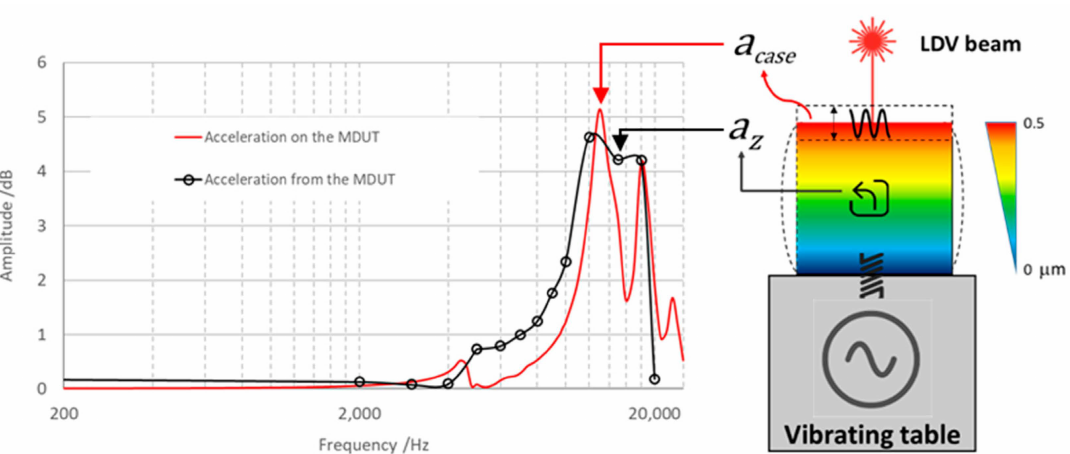
Figure 13. Comparison between the acceleration amplitude, a case , measured on the upper surface of MDUT by the Laser-Doppler Vibrometer (red curve), the acceleration amplitude, a z , measured from the signal output of the sensing element embedded in the resin case (black curve) and a schematic picture of the mechanical behavior and deformations occurring during